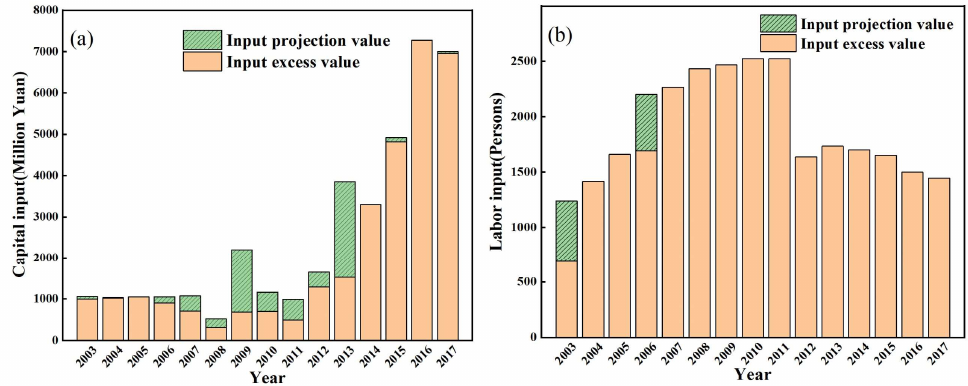
Figure 5. Projection and excess value of capital ( a ) and labor ( b ) inputs of water pollution control.